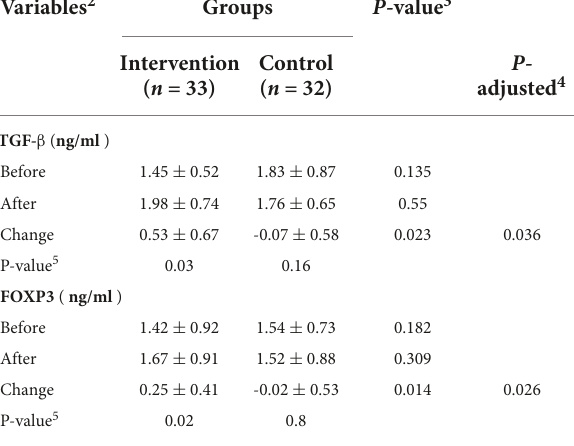
TABLE 3 Comparison of TGF- β and FOXP3 levels between groups at the baseline and end of the study 1